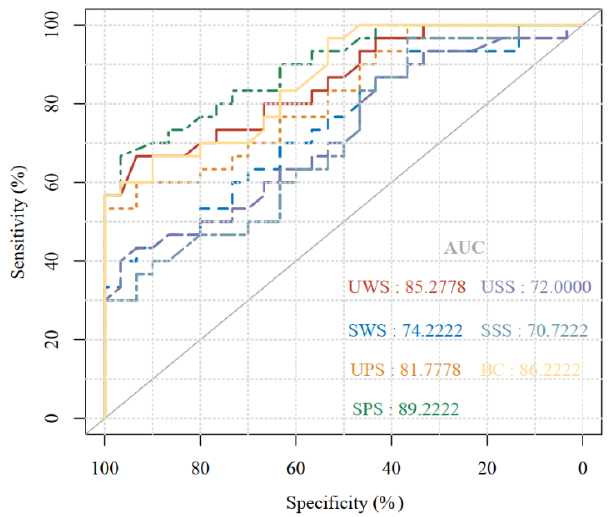
Figure 5. The ROC curve of cortisol in the diagnosis of depression.